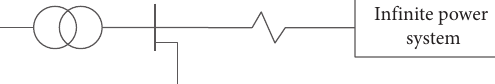
u attack under different attack modes.